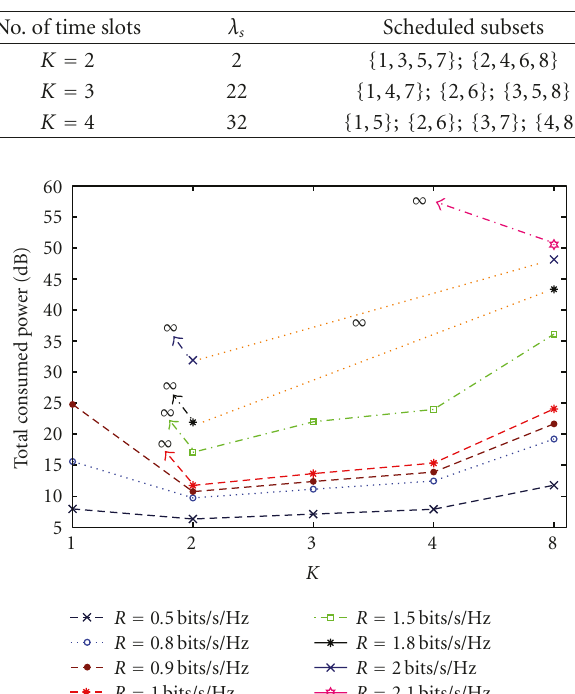
Table 1: Outcomes of the DCLS algorithm for the ring network of 8 links and di ff erent values of K .